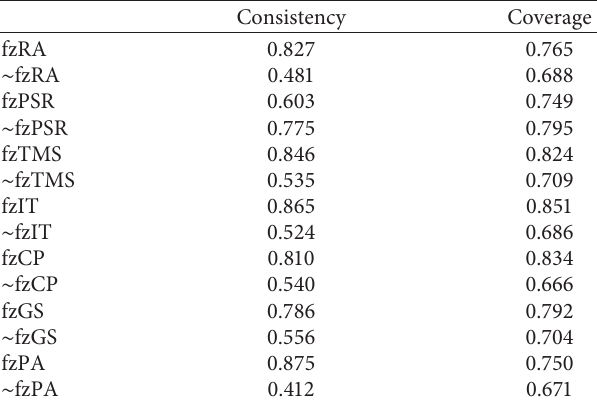
Table 3: Analysis of necessary